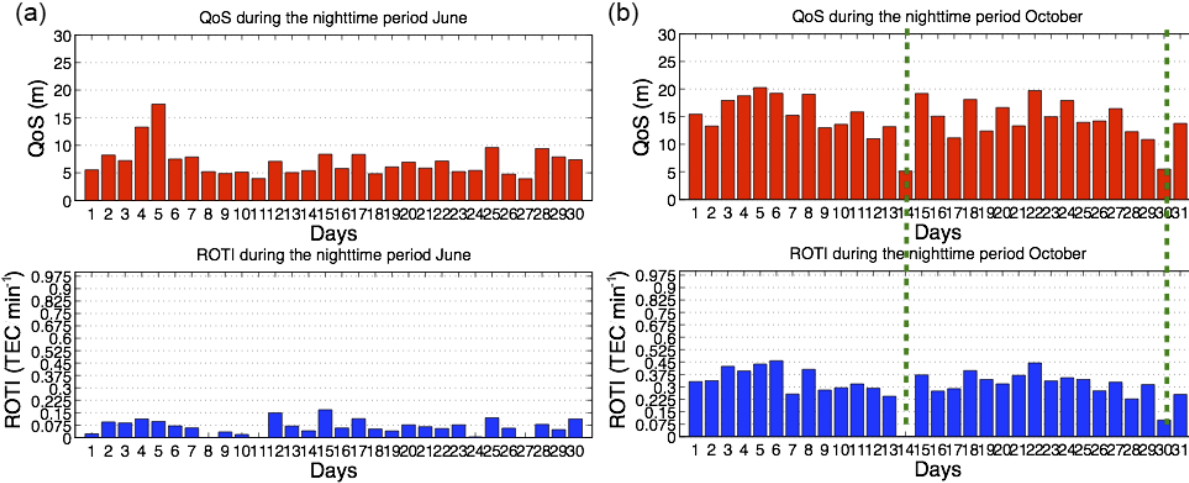
Figure 3. Correspondence of ionospheric irregularity inhibition with SBAS performance in June (left) and October (right) 2013.